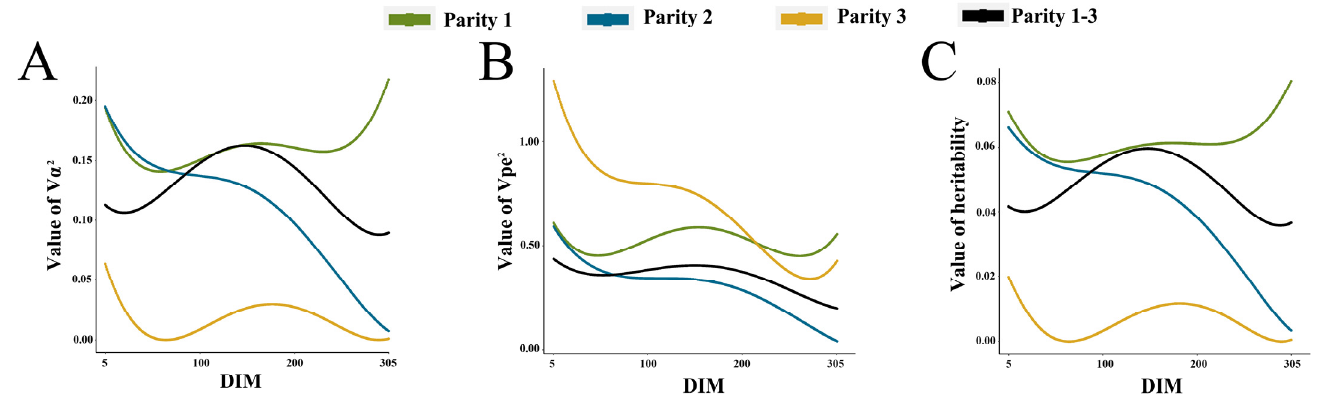
Figure 1. The curves of phenotypic and genetic parameters of SCS within lactations of different parities. ( A ) The change in genetic variance component estimates of traits during lactation. ( B ) The change in permanent environmental effect variance component estimates of traits during lactation. ( C ) The change in heritability estimates of traits during lactation (green, blue, orange, and black lines represent the first parity, second parity, third parity, and first three parities, respectively). DIM: days in milk.